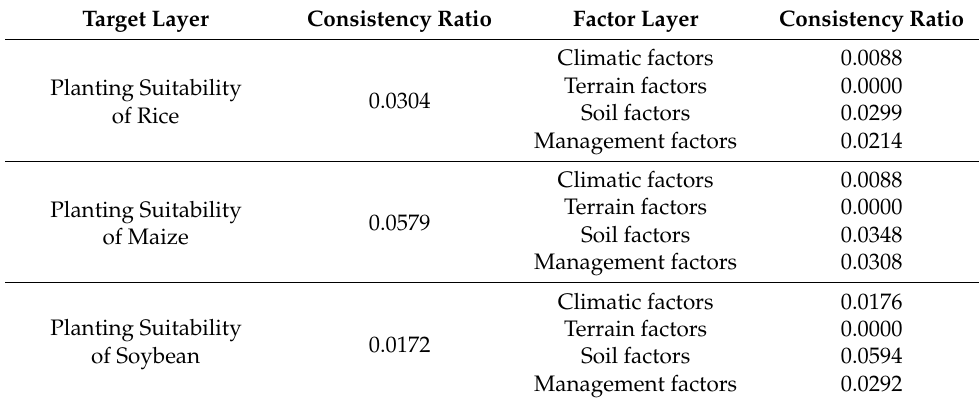
Table 2. Consistency test result of evaluation indicators